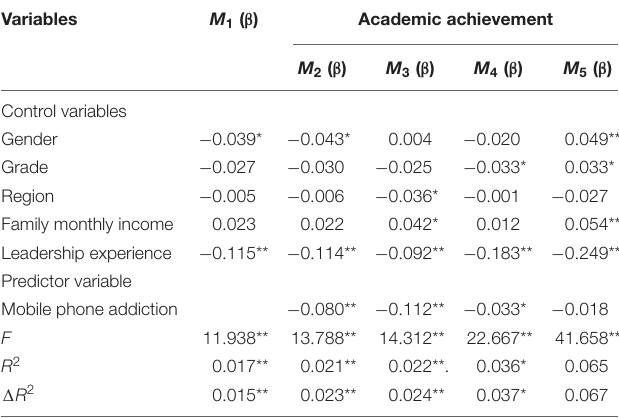
TABLE 3 | Influence of mobile phone addiction on academic achievement.